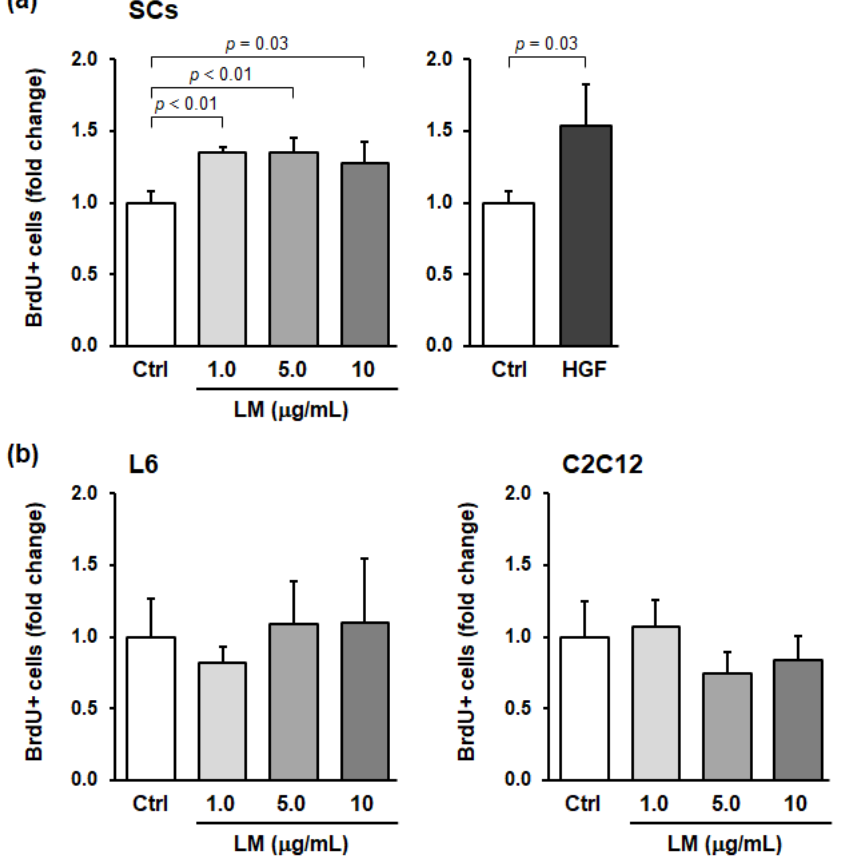
Figure 1. Lemon myrtle extract (LM) promotes BrdU incorporation into skeletal muscle satellite cells (SCs) but not in myoblasts in vitro. ( a ) Effects of LM and recombinant human hepatocyte growth factor (HGF) treatment on BrdU incorporation into SCs. ( b ) Effects of LM treatment on BrdU incorporation into L6 rat myoblast cells (left), and C2C12 mouse myoblast cells (right). SCs and myoblast cells were treated with LM or HGF for 22 h and then incubated with BrdU for an additional 2 h. The concentration of LM used is indicated in the figure. The HGF concentration used was 5 ng/mL. BrdU-positive (BrdU + ) cells were detected by immunocytochemistry and the number of cells was counted. BrdU incorporation into each cell is expressed as BrdU + cells per total cells and is shown as a fold change compared to the control (Ctrl). Data represent the mean ± standard deviation (SD) of three independent cultures. Significant differences ( p < 0.05) relative to the Ctrl are indicated in the figure, and non-significant differences ( p > 0.05) are not shown in the figure.